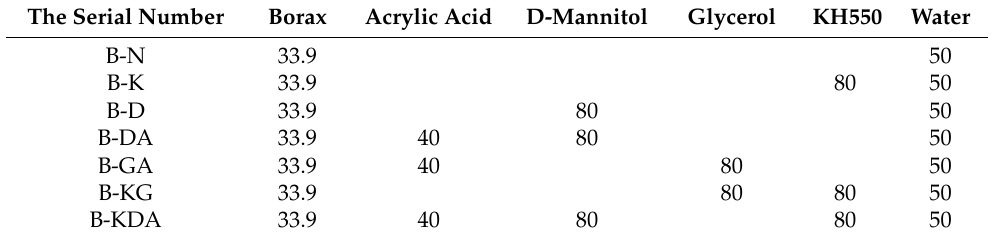
Table 3. The ratio of each component under varying